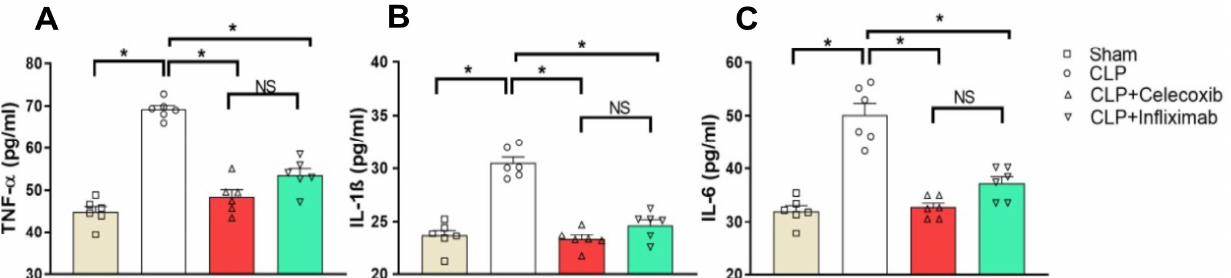
Figure 2. CLX and IFX ameliorate serum inflammatory profiles in septic rats. The bar charts show the effects of CLX and IFX on serum cytokines. ( A ) TNF- α , ( B ) IL-1 β , ( C ) IL-6. ANOVA was used to analyze the results, followed by the Tukey–Kramer test for multiple comparisons. For each group, n = 6. CLP: cecal ligation and puncture, CLX: celecoxib, IFX: infliximab. * denotes significant at p < 0.05.